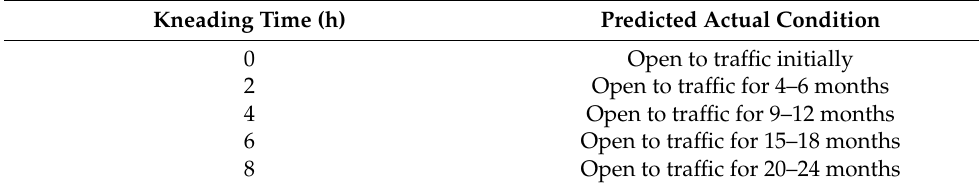
Table 5. Predicted relation of kneading time and actual pavement condition.